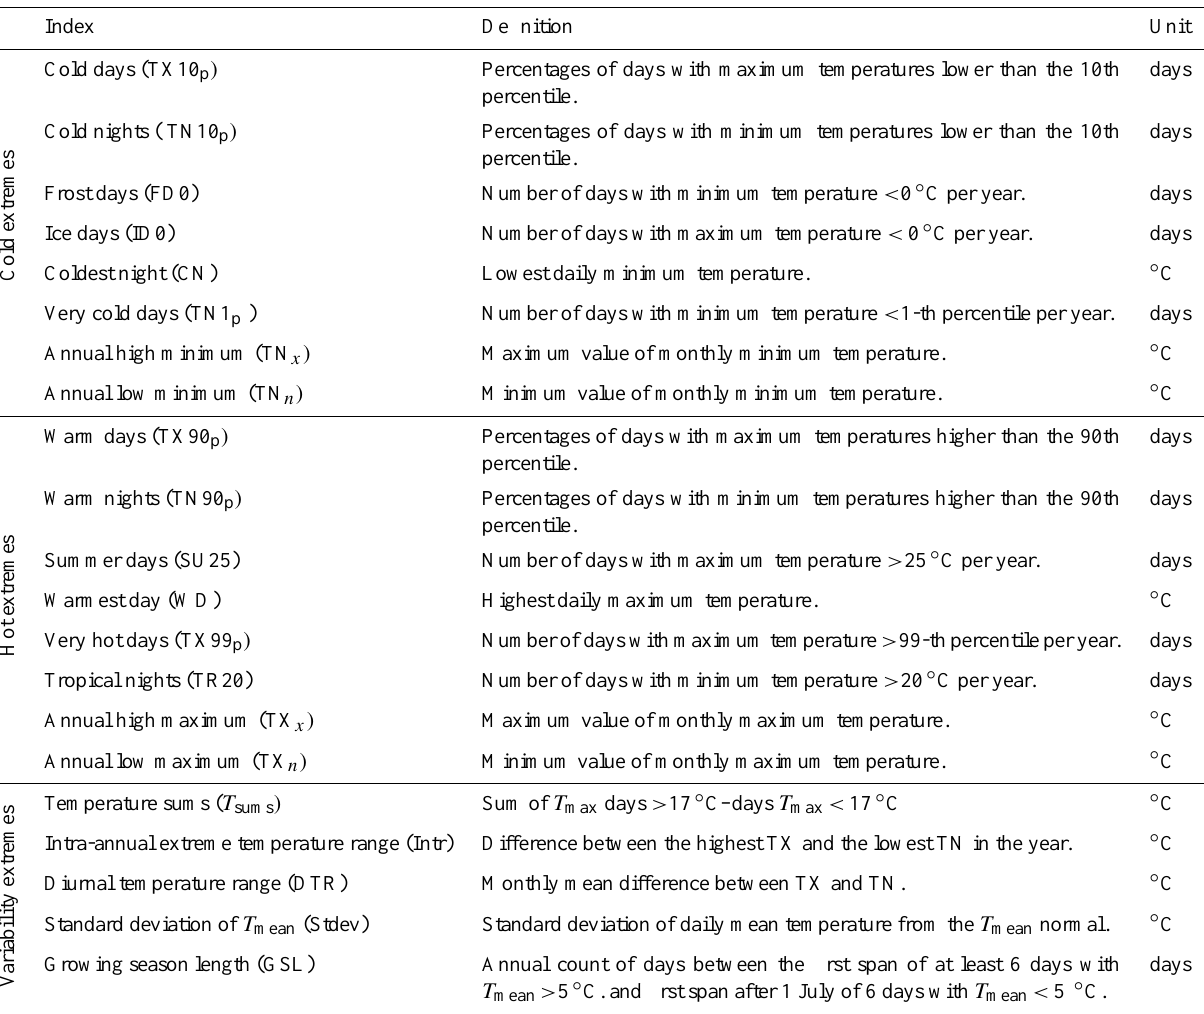
Table 1. List of all temperature indices used in this study and their